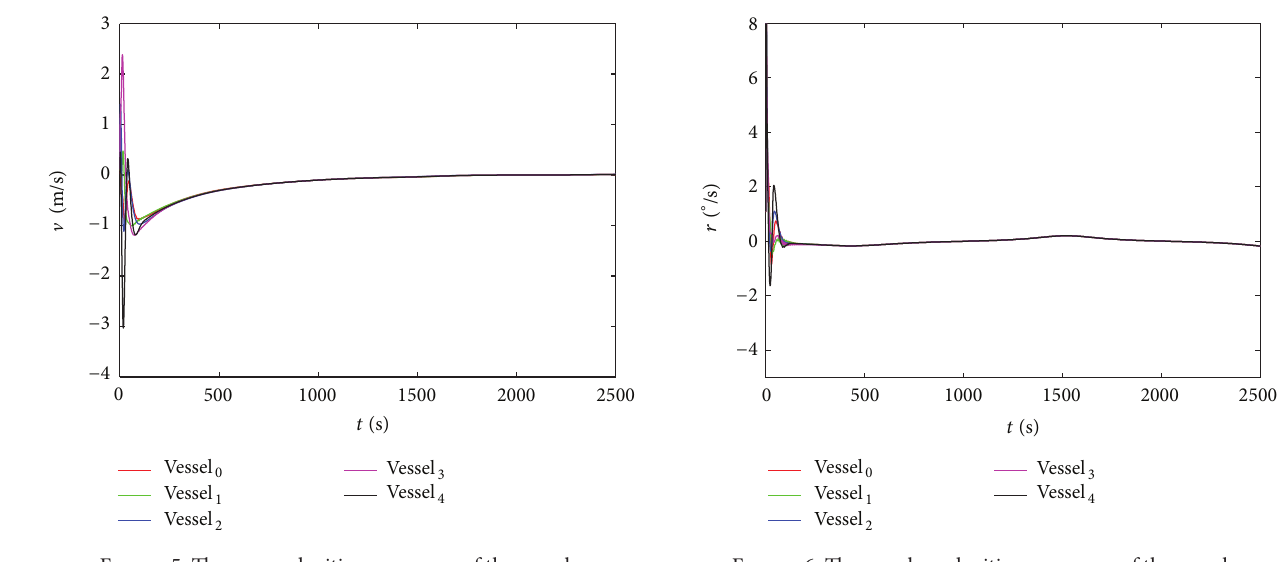
Figure 6: The angular velocities consensus of the